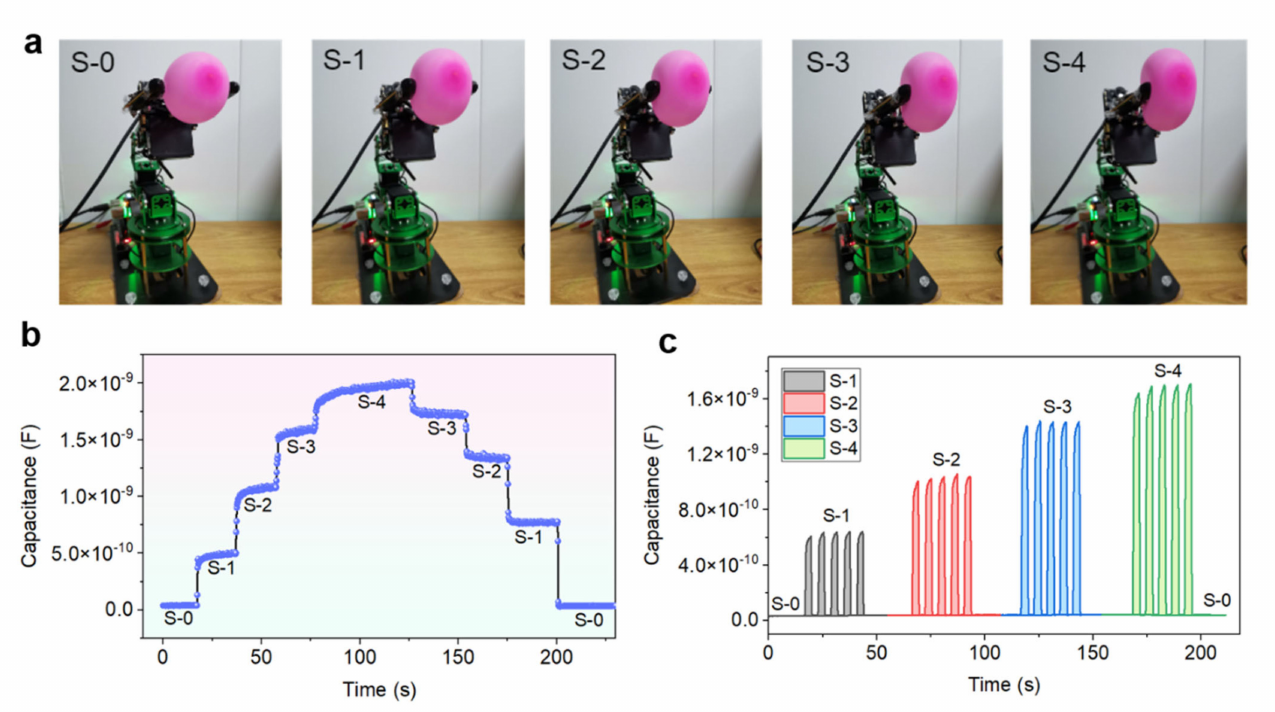
Figure 8. Monitoring of the force variation during manipulation of an object with a robotic hand with the flexible iontronic pressure sensors. ( a ) Digital pictures showing that a robotic hand grasps an object (e.g., a balloon is used here) with different forces. The grasping force increases gradually from the motion of S-0 to the motion of S-4. ( b ) Typical response signals of the flexible sensors during grasping and releasing of the object in stagewise manner, i.e., the motions of S-0 to S-4 were held for certain period of time before conducting the next motion. ( c ) Signal outputs of the sensors recorded when the robotic hand grasps the balloon repeatedly with different motions (S-1, S-2, S-3, and